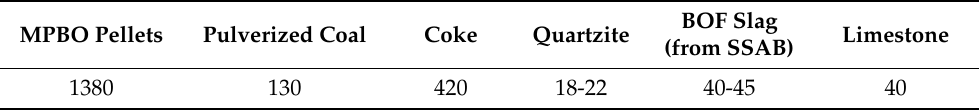
Table 1. Specific consumption of charged and injected materials in the experimental blast furnace (EBF) campaign 32 (kg /